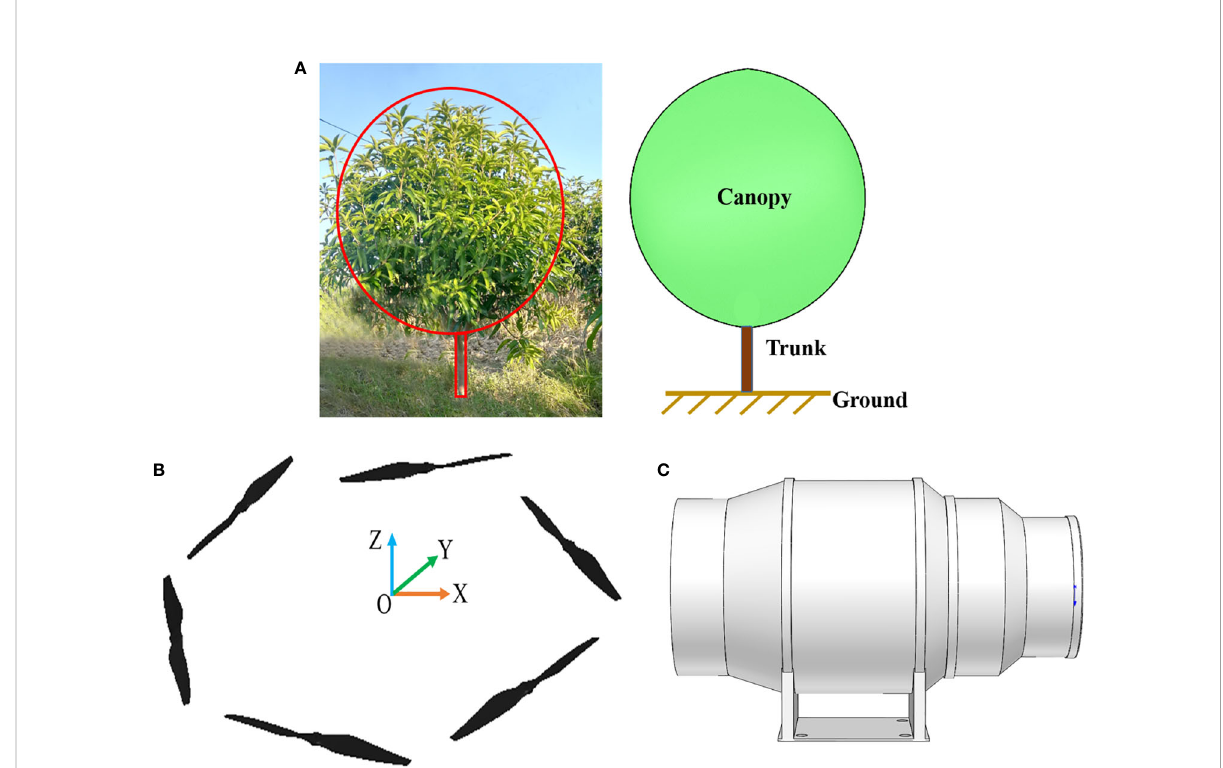
FIGURE 5 CFD geometric model construction. (A) Simpli fi ed model of fruit tree. (B) Simpli fi ed model of plant-protection UAV. (C) Simpli fi ed model of swing-arm